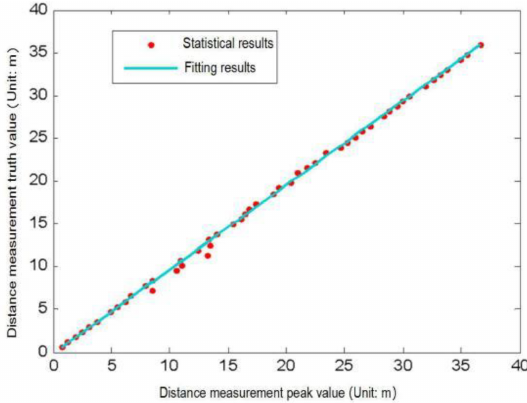
Figure 6. Statistical results and fitting of the peak and true values of distance